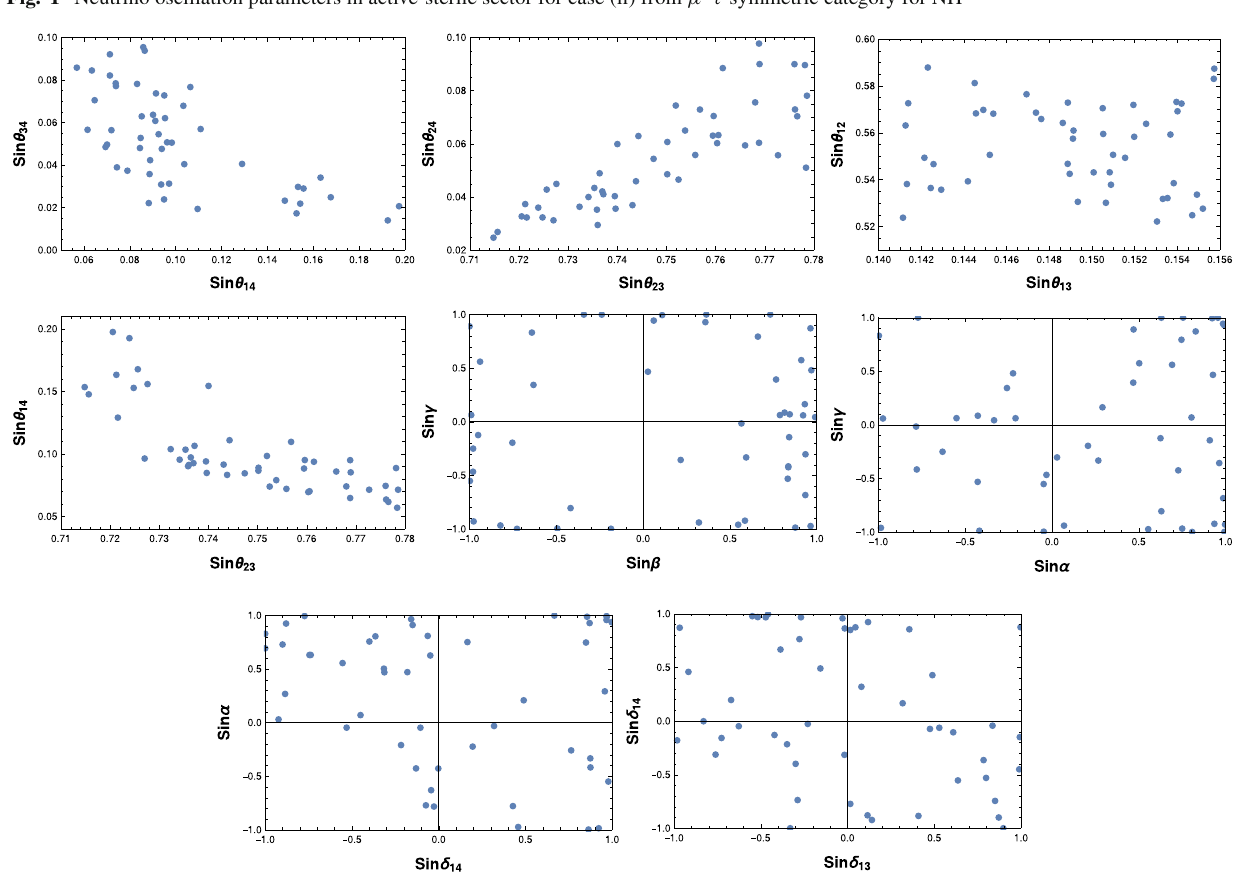
Fig. 2 Neutrino oscillation parameters in active-sterile sector for case (iii) from μ – τ symmetric category for NH correlations between active-sterile mixing angles θ 34 − θ 14 and between Majorana CP phases α − γ after the constraint equations corresponding to μ – τ symmetric subclass (ii) were solved for 1 million random points. The resulting acceptable number of solutions is only a handful, as can be seen from the plots. The same trend is repeated for the other two sub- classes (iii), (iv) as well, the correlations for which are shown in Figs. 2 and 3